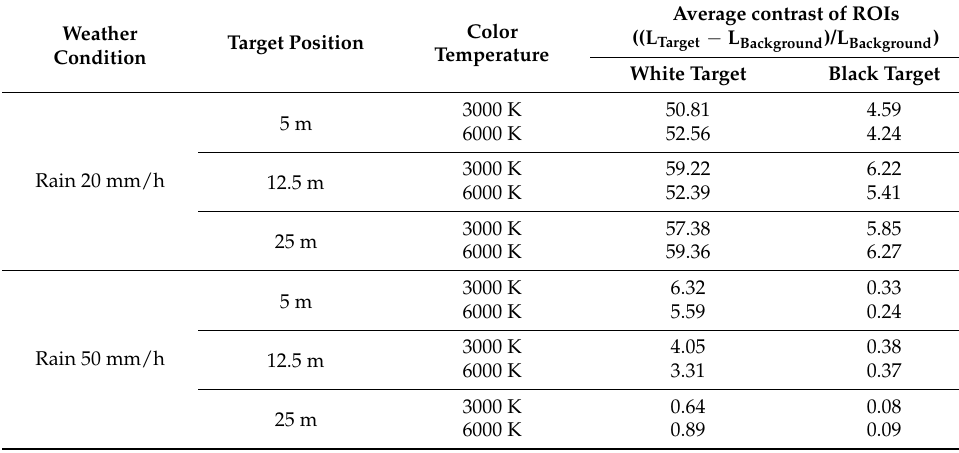
Table 13. Average contrast of ROI in rain